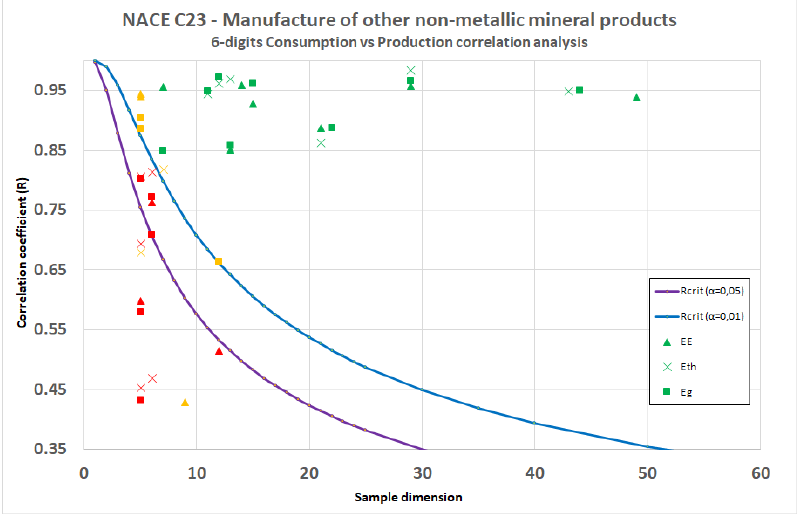
Figure 9. NACE C23 four-digit consumption vs. production correlation analysis. Purple and blue curves represent critical values of the Pearson correlation coefficient (R crit ) as a function of sample dimension for a confidence value α of 0.05 and 0.01. The indicators (triangles for electrical energy consumption, crosses for thermal energy consumption, and squares for global energy consumption) represent the correlation coefficient values (R) of the linear regressions for the different ATECO six-digit subcode sets. The indicators have been coloured according to the P-value of the linear re-gression. In red are the indicators for which pValue > 0.05; in orange, those for which 0.05 < pvalue <0.01; and in green, the correlations with pvalue <0.01.